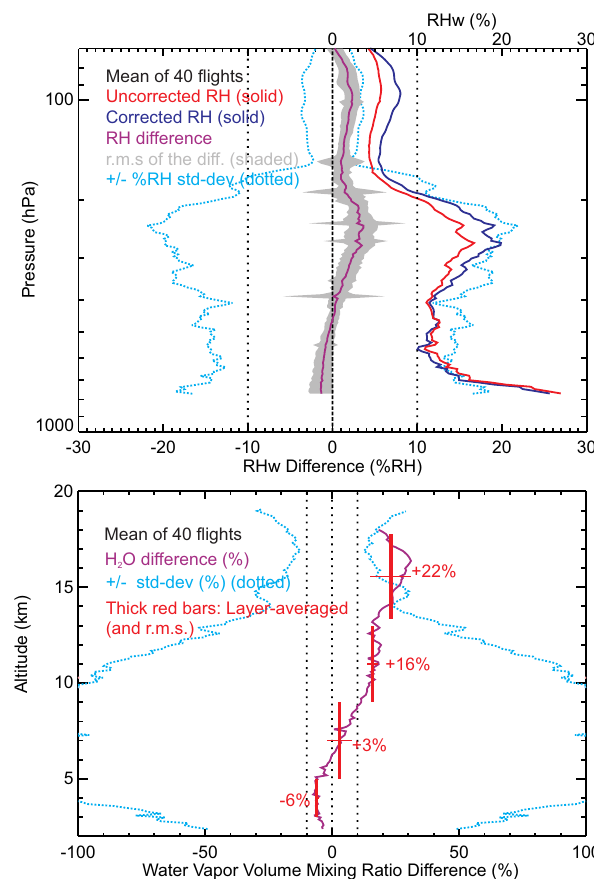
Fig. 1. Campaign-mean mixing ratio profiles (top) measured si- multaneously by RS92 and CFH, and their difference (bottom). Both corrected and uncorrected RS92 are compared to CFH. The thick, red (uncorrected) and orange (corrected) vertical and horizon- tal bars indicate layer-averaged differences and standard deviations respectively.